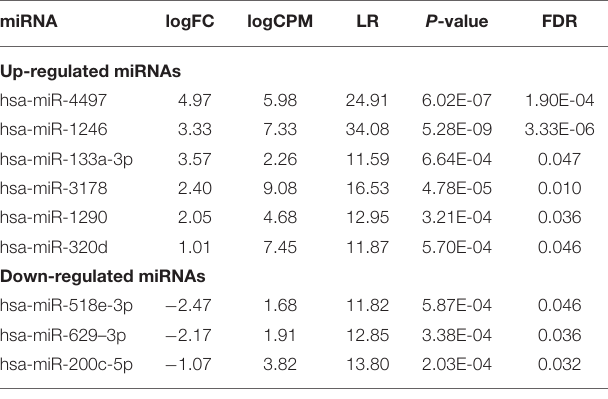
TABLE 2 | Differentially expressed exomiRs in type 1 diabetes vs.